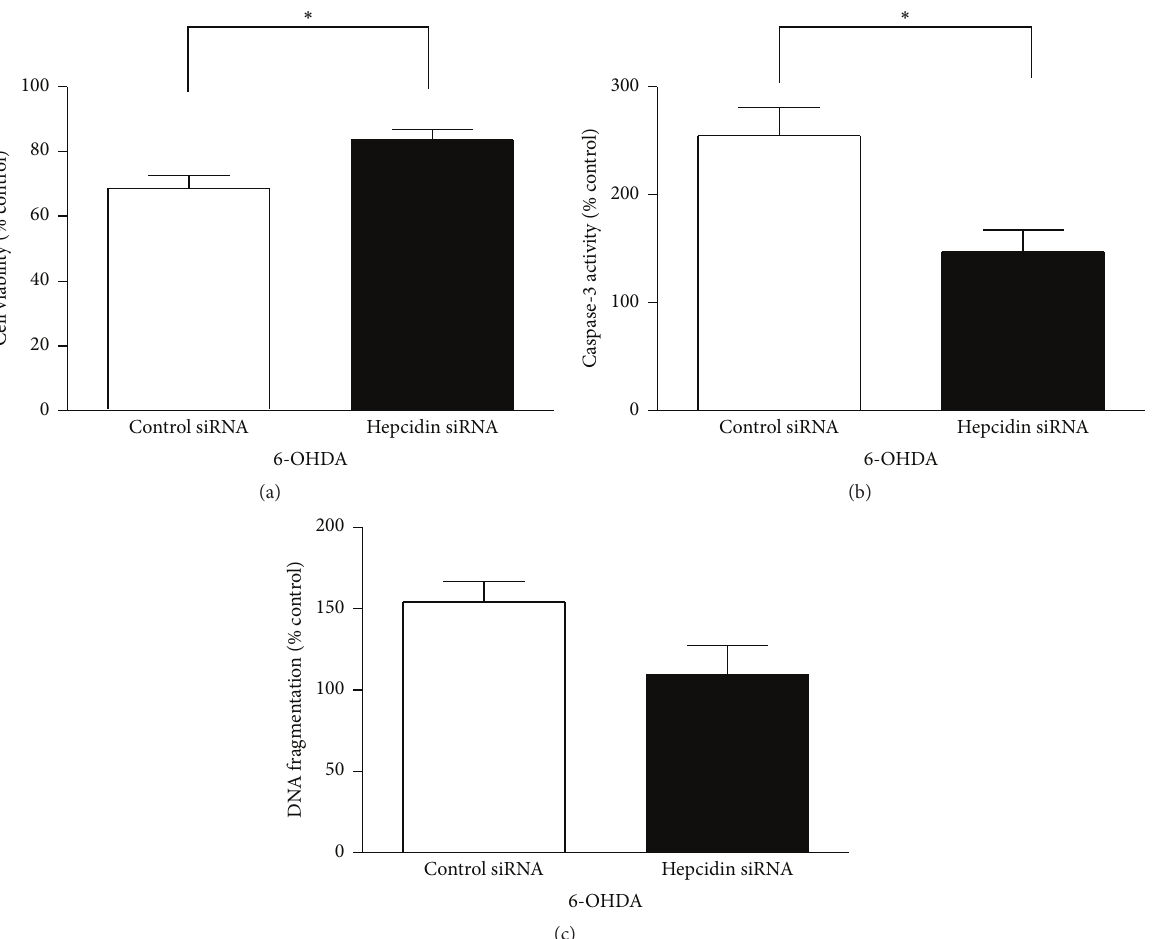
Figure 2: The role of hepcidin knockdown in 6-OHDA induced cytotoxicity measured by MTT ((a), 𝑛 = 6 ), caspase-3 activity ((b), 𝑛 = 4 -5), and DNA fragmentation ((c), 𝑛 = 4 ) in N27 cells. Cells were treated with 100 𝜇 M 6-OHDA for 6 hours and the values (mean ± SEM) are normalized to their respective controls without 6-OHDA treatment; ∗ 𝑃 < 0.05 ; difference between two groups was based on Student’s 𝑡 -test; control siRNA: scrambled small interfering RNA; hepcidin siRNA: hepcidin small interfering